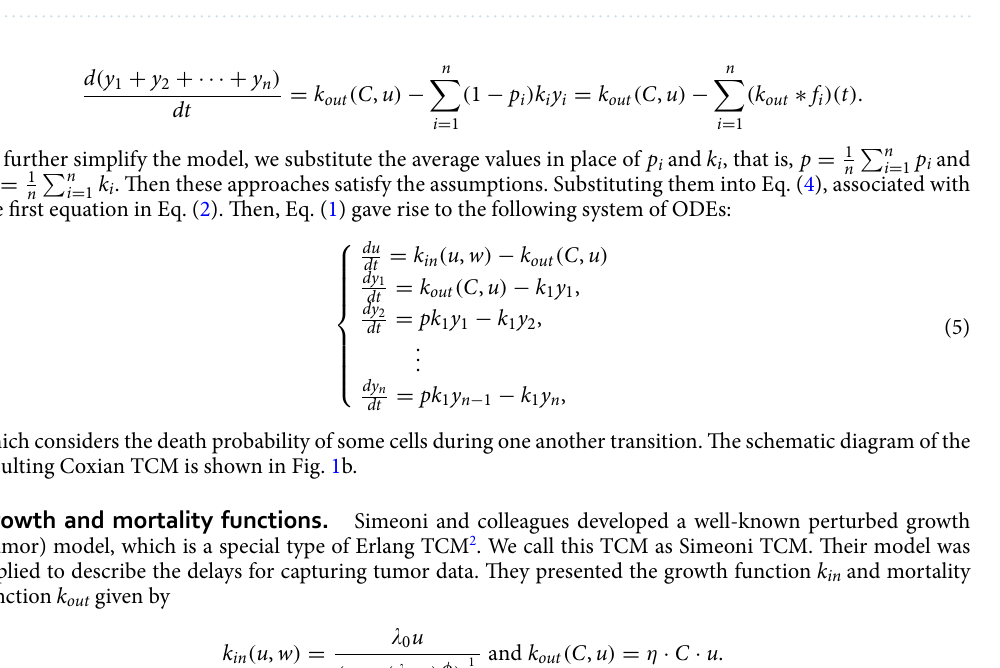
Figure 2. ( a ) 10 times dosing regimen per day from day 13 is plotted. ( b ) PK profile are plotted. Red one represents observed data after final injection. ( c ) PK profile in the study 7 is